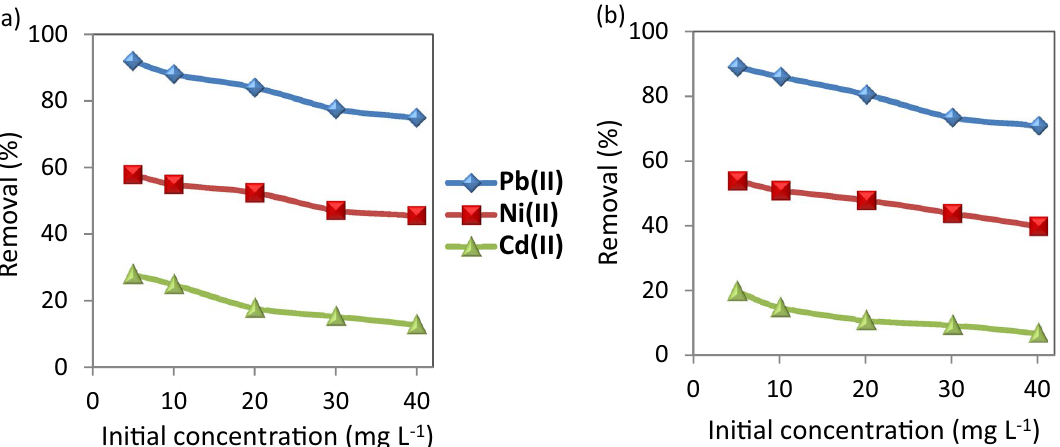
Figure 7. Effect of initial metal concentration on the removal of the studied metal ions using ( a ) CuO NPs-1 and ( b ) CuO NPs-2 at contact time: 60 min, and dose: 0.33 g L −1